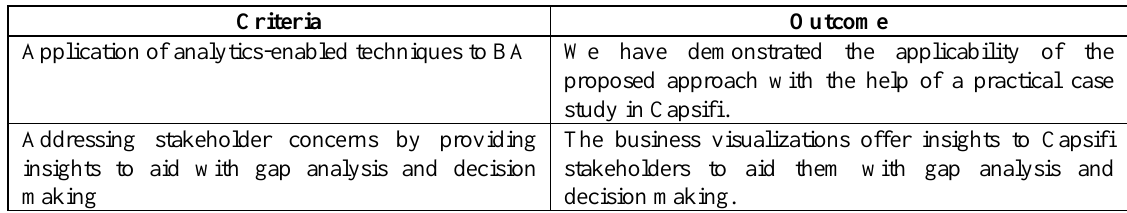
Table 6. Metric evaluation